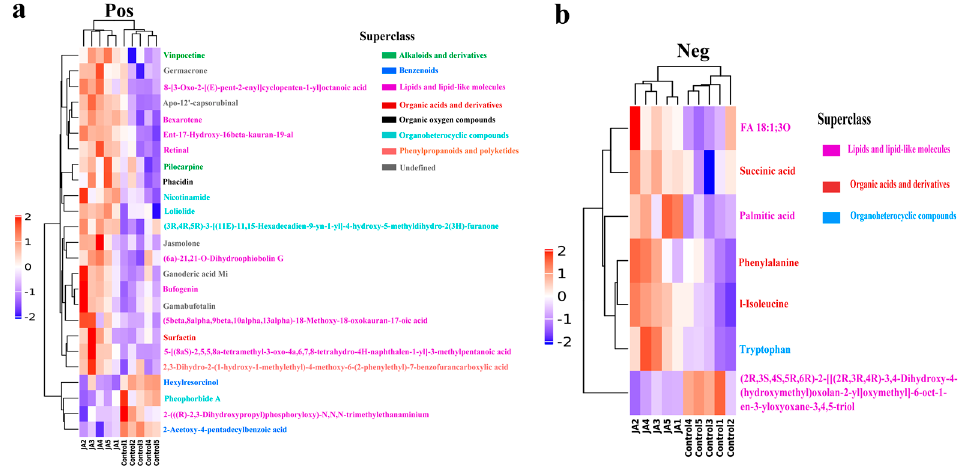
Figure 5. Heat map of differential metabolites in kidney bean leaves induced by jasmonic acid in positive ( a ) and negative ( b ) ion modes. Metabolite names of the same color are in the same superclass. Orthogonal partial least squares discriminant analysis (OPLS-DA) variable importance in the projection (VIP) > 1 and p < 0.05 were used as criteria to screen significantly different metabolites. Table 1. Differential metabolites significantly upregulated in jasmonic acid-induced kidney bean leaves, compared with the control.